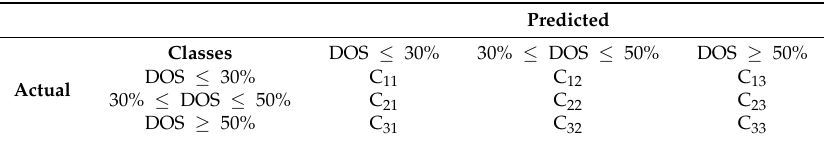
Table 7. Confusion Matrix of three classes.